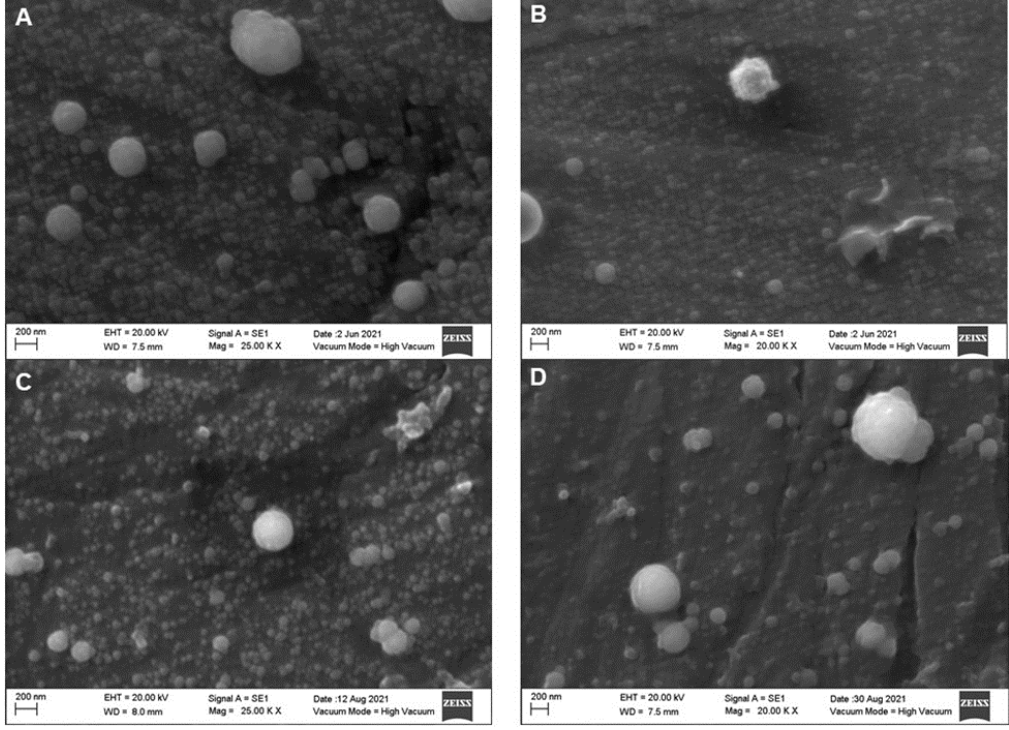
Figure 2. Scanning electron microscopy micrographs of an untreated milk sample. Whole, unhomog- enized, raw milk ( A ); whole, homogenized raw milk ( B ); skim, unhomogenized raw milk ( C ); skim, homogenized raw milk ( D